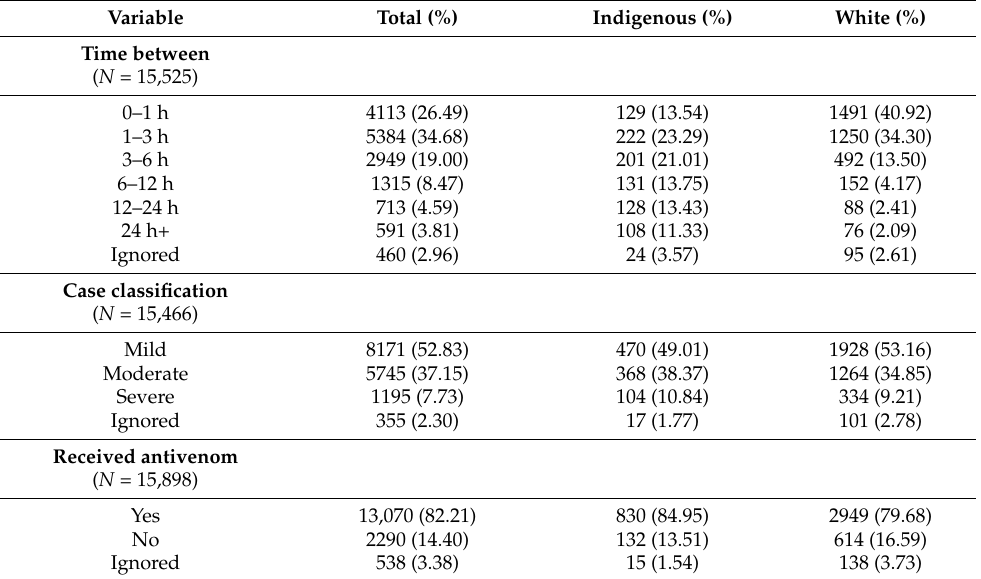
Table 3. Number of snakebites by time between accident and health care, by race, rural population, Brazil, 2017.